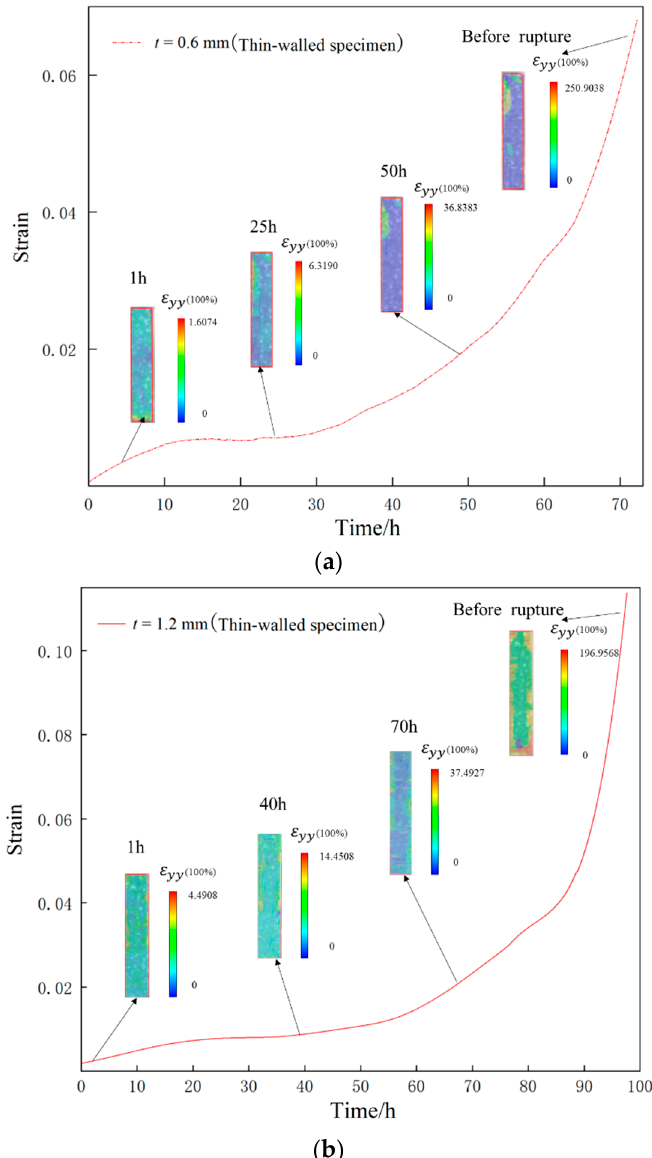
Figure 12. Full-field creep strain ε yy contour maps of the thin-walled specimens tested at 980 °C/250 MPa: ( a ) 0.6 mm thick specimen, ( b ) 1.2 mm thick specimen.